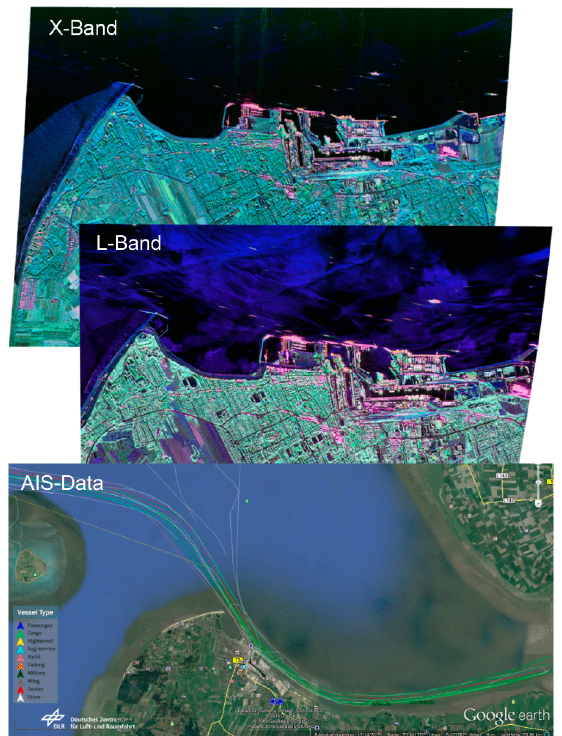
Figure 22. Simultaneously acquired fully polarimetric X- and L-band data of the region around Cuxhaven and the corresponding AIS data.